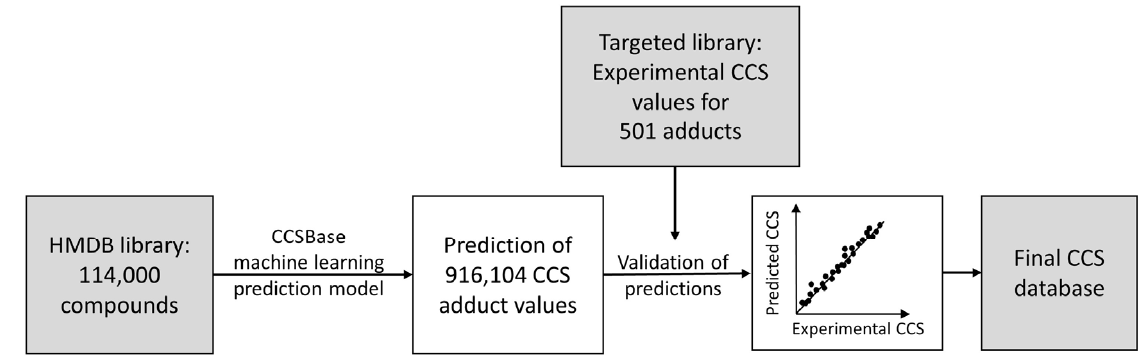
Figure 3. Workflow of CCS prediction.